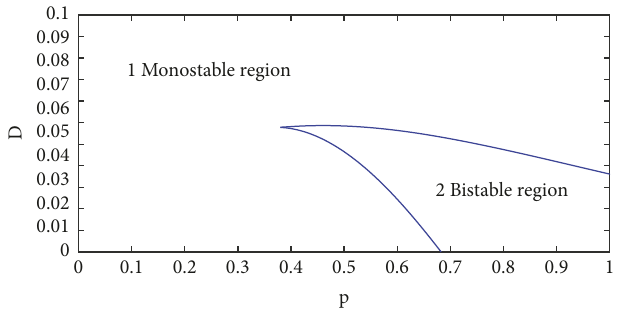
Figure 4: The transition set curve of system (28).